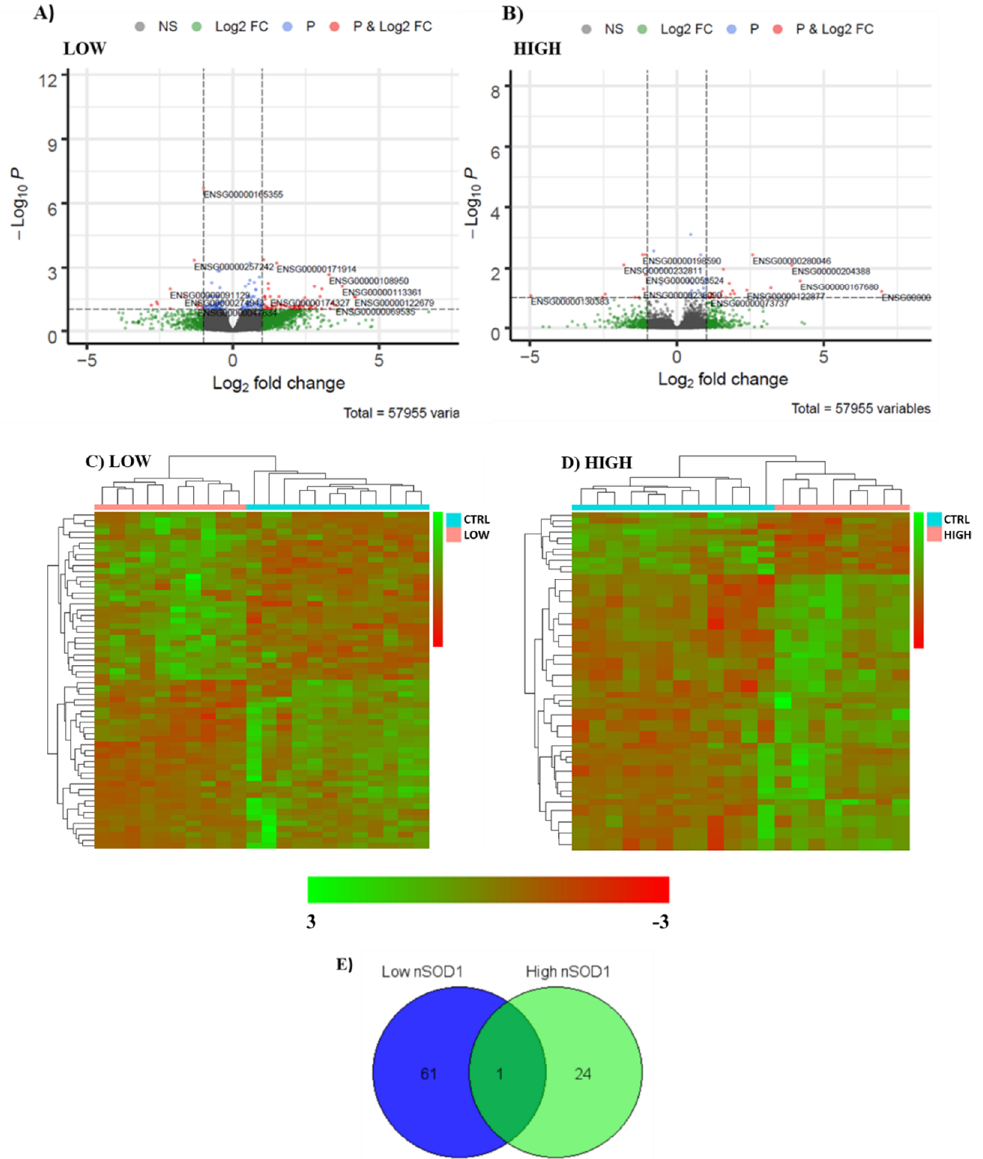
Figure 2. Differential expression analysis in low- and high-nSOD1 PBMCs of sALS patients. Volcano plots. Panel ( A ) shows DE genes in low-nSOD1 patients, while panel ( B ) shows DE genes in high- nSOD1 patients. The expression difference is considered significant for a log2 fold change of ≥1 or ≤−1 ( x -axis) and for false discovery rate ≤ 0.1 ( y -axis). Red dots represent significantly up- and down- regulated genes that have |log2(fold change)| ≥ 1 and a p -value ≤ 0.05. Blue, green and gray dots represent detected DE genes that are not significant, because they do not satisfy both requirements. (NS = nonsignificant; log2FC = satisfying fold change criteria; P: satisfying p -value criteria; P and log2FC: satisfying both fold change and p -value cut-off). The top 11 DE genes are labeled (Ensembl ID). Heat maps. Expression profiles of differently expressed genes in sALS patients and healthy controls. Panel ( C ) compares RNAs in low-nSOD1 patients (pink bar) and the control samples (light blue bar), while panel ( D ) compares RNAs in high-nSOD1 patients (pink bar) and the control sam- ples (light blue bar). Venn diagram. Differentially expressed genes in common between the two nSOD1 ALS groups ( E ).